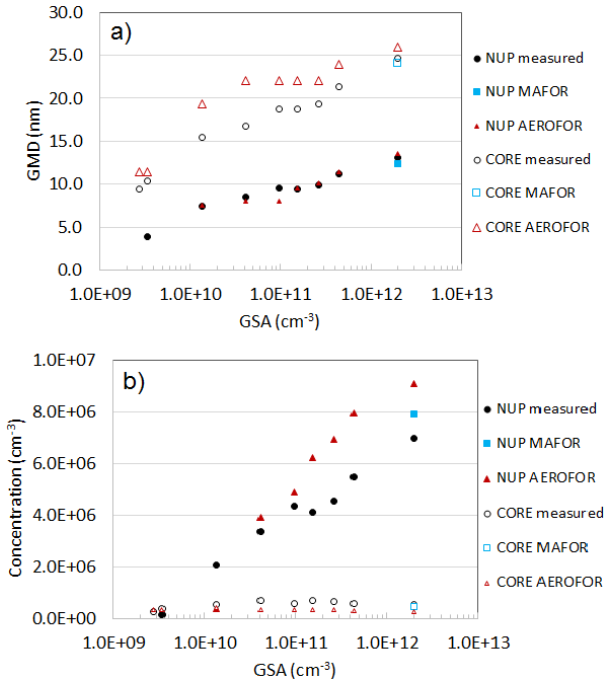
Figure 6. Mean diameters (GMD) (a) and number concentration of particles > 3nm (b) at the end of the simulation for the volatile nucleation mode and the core mode. The nucleation mechanism was HET. Also shown are the measured values at the end of the ageing chamber.